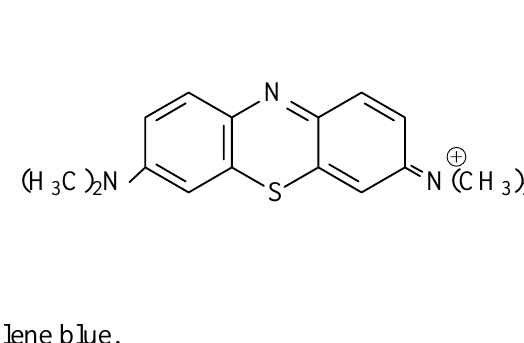
Figure 1. Structure of methylene blue.